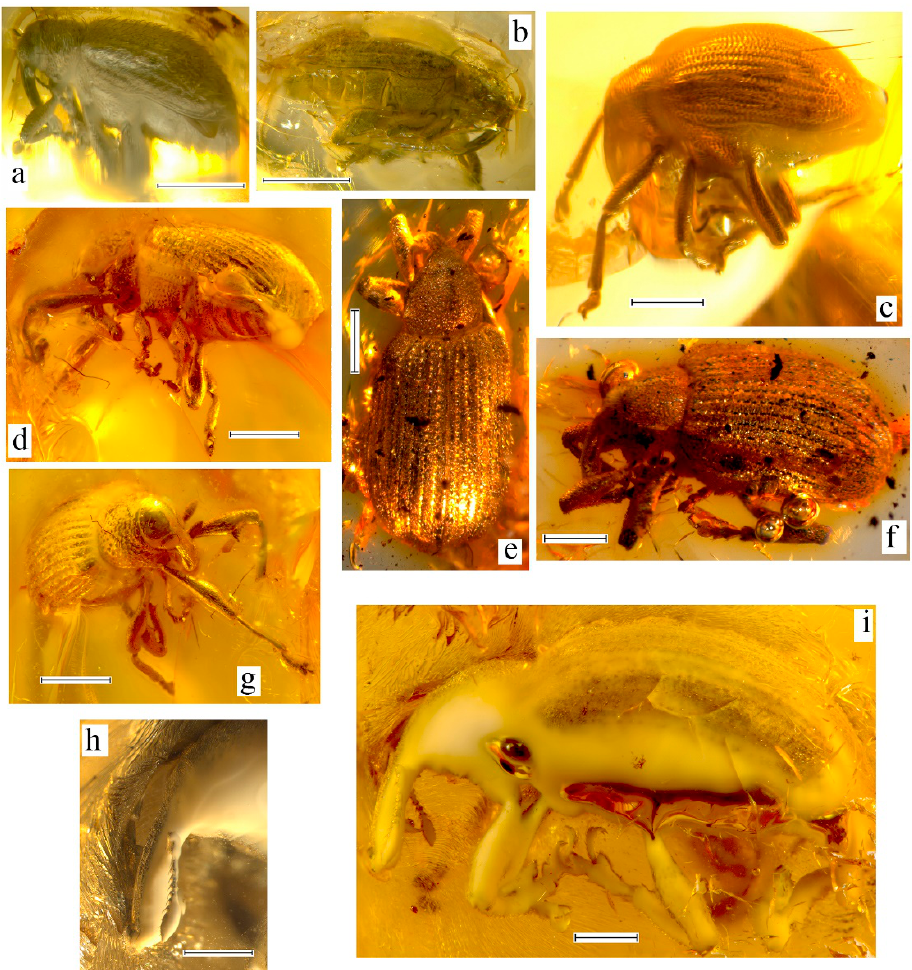
Figure 10. Habitus of Curculionidae from Baltic amber. ( a , b ) Orchestes tatjanae , holotype, ISEA , no. BA2014/4: body, laterally, on the left ( a ); body, laterally, on the right ( b ). ( c ) Eocenesibinia prussica , holotype, ISEA , no. BA2013/4, body, laterally. ( d , g ) Paleodontopus smirnovae gen. et sp. nov. , holotype, KRAM , no. 6504: body, ventro-laterally ( d ); body, laterally ( g ). ( e , f ) Palaeophelypera kuscheli , holotype, ISEA, no. BA2012/4: body, dorsally ( e ); body, laterally ( f ). ( h , i ) Limalophus poinari sp. nov. , holotype, ISEA , no. BA2017/6: rostrum and head, laterally ( h ); body, laterally ( i ). Scale bars: 1.0 mm. Section 2 for names of See Section 2 for names of collections.